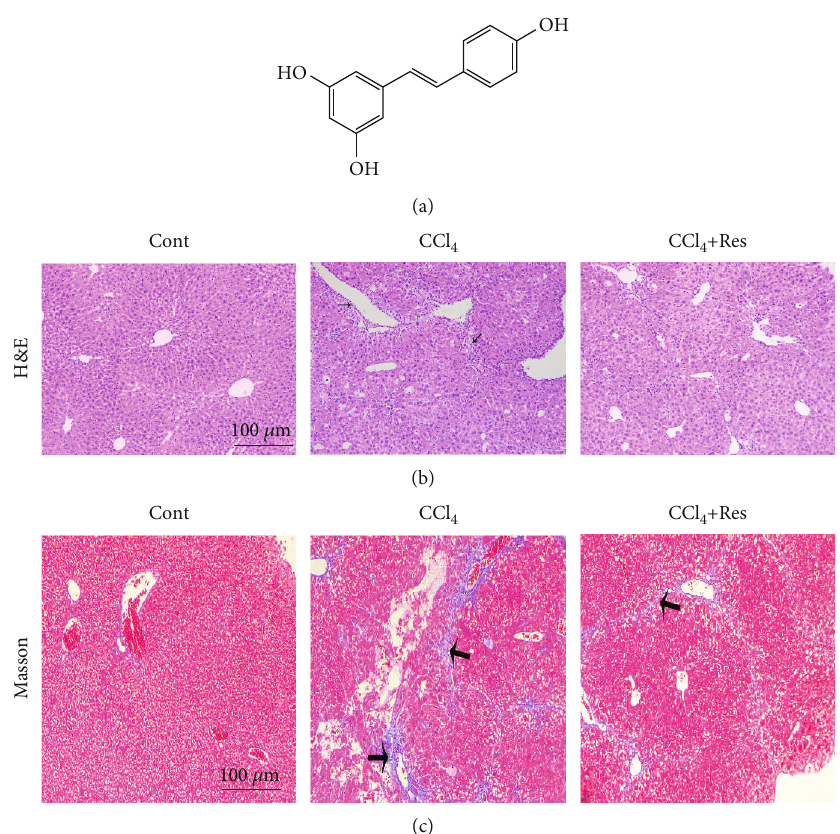
Figure 1: Res attenuates CCl -induced liver fi brosis in mice. (a) Chemical structure of Res. (b) H&E staining. (c) Masson trichome staining. 4 Magni fi cation: × 100. Narrow arrow: in fl ammatory cell in fi ltration. Wide arrow: collagen